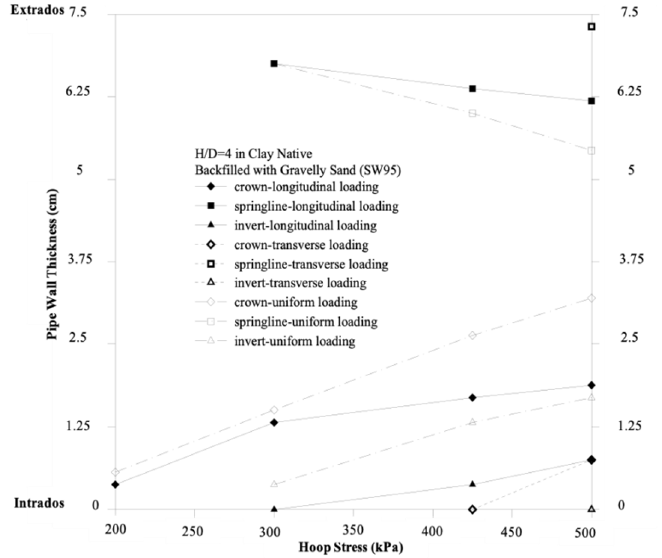
Figure 5. Crack depth through the pipe wall under longitudinal, transverse, and uniform loading conditions.